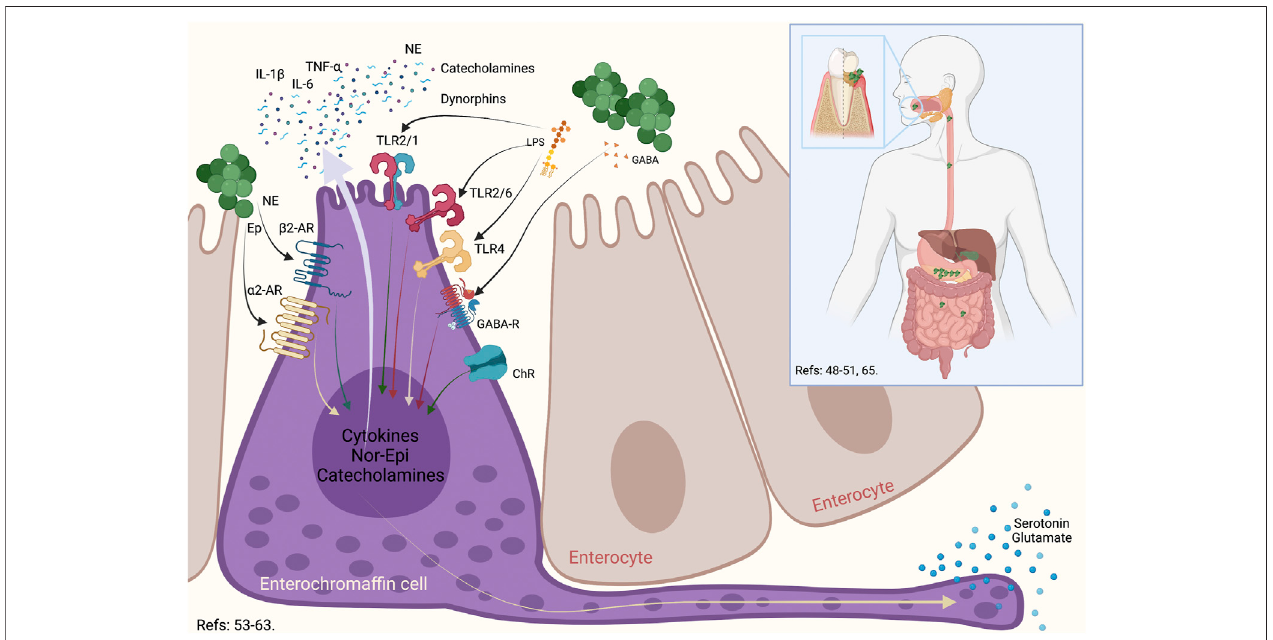
FIGURE 1 | Enterochromaf fi n cell role in the oral-gut communication. During an oral dysbiosis, the increase in anaerobic bacteria associated with periodontitis producesan increase in theswallowedbacterial load.Thesebacteria, uponreachingthe intestine, can generate animbalancein thegutmicrobiota. Oneofthecells that is capable of recognizing both its own bacteria and bacteria that are relevant to the gut microbiota are the enterochromaf fi n. These cells possess a series of surface receptors, such as TLR2, TLR4, GABA, ChR, α 2-AR, and β 2-AR, which allows this cell to respond to a wide variety of bacteria, their virulence factors or even, the neurotransmitters that some of them produce. In this way, normobiosis or dysbiosis differentially activates enterochromaf fi n cells, which through glutamate or serotonin stimulate efferent vagal neurons to have an associated response. TLR: Toll Like Receptor, GABA: γ -Amino Butyric Acid, ChR: Cholinergic receptor, α 2-Adrenergic Receptor, β 2-Adrenergic Receptor, NE: Nor-Epinephrin, Ep: Epinephrin, IL: Interleukin, TNF: Tumoral Necrosis Factor.